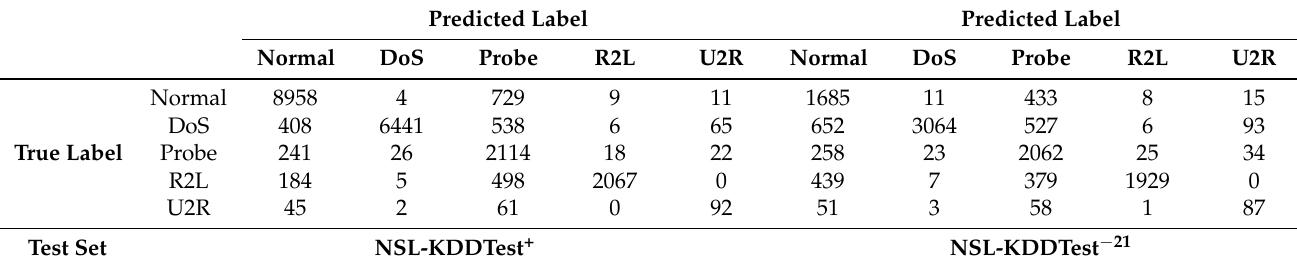
Table 5. Confusion matrix for standard LSTM model trained with all 41 features.